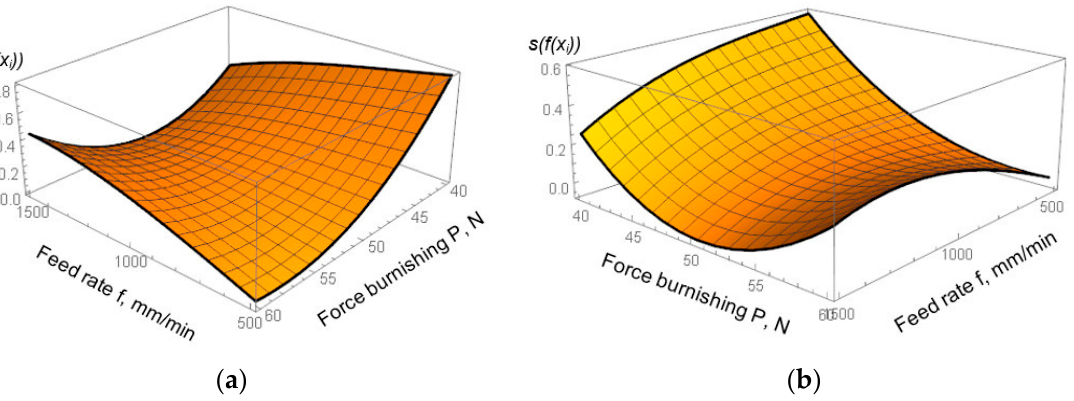
Figure 13. Plot of the objective function of a multi-criteria optimization ( a ) u i = 0.142, ( b ) u 1,2 = 0.25, u 3–7 = 0.1. u 3–7 =